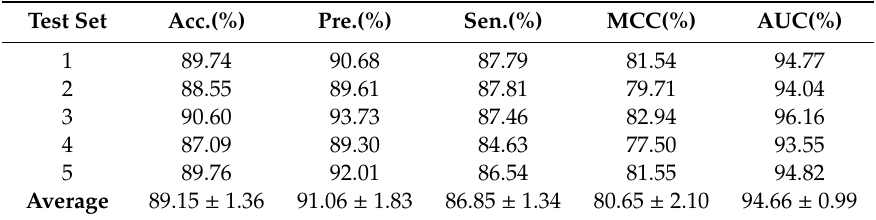
Table 1. The five-fold cross-validation results achieved on enzyme dataset by using the proposed model.